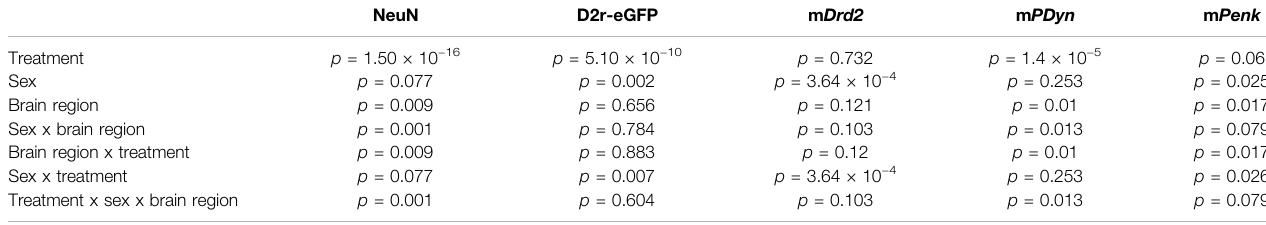
TABLE 3 | Outcome of 3-way ANOVA. NeuN D2r-eGFP m Drd2 m PDyn m Penk Treatment